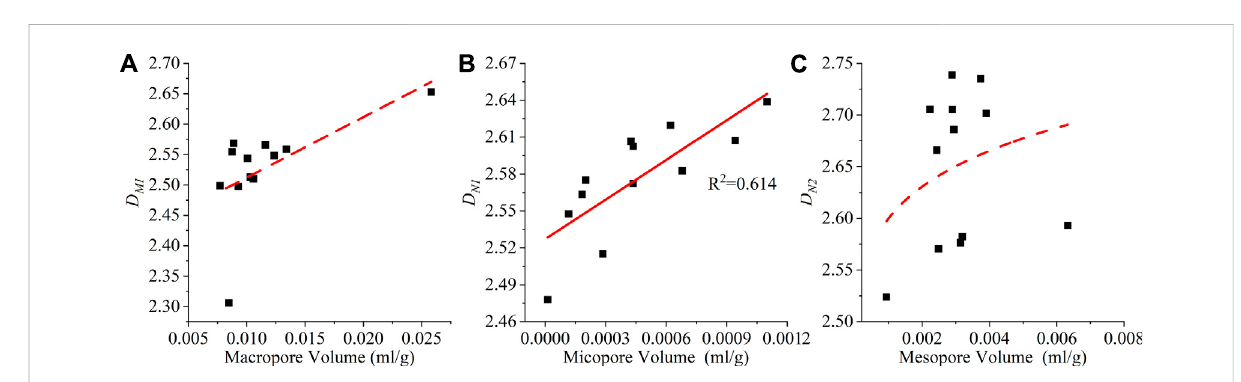
FIGURE 12 Relationship between fractal dimensions and corresponding pore volume: (A) D M1 ; (B) D N1 ; (C) D N2 .